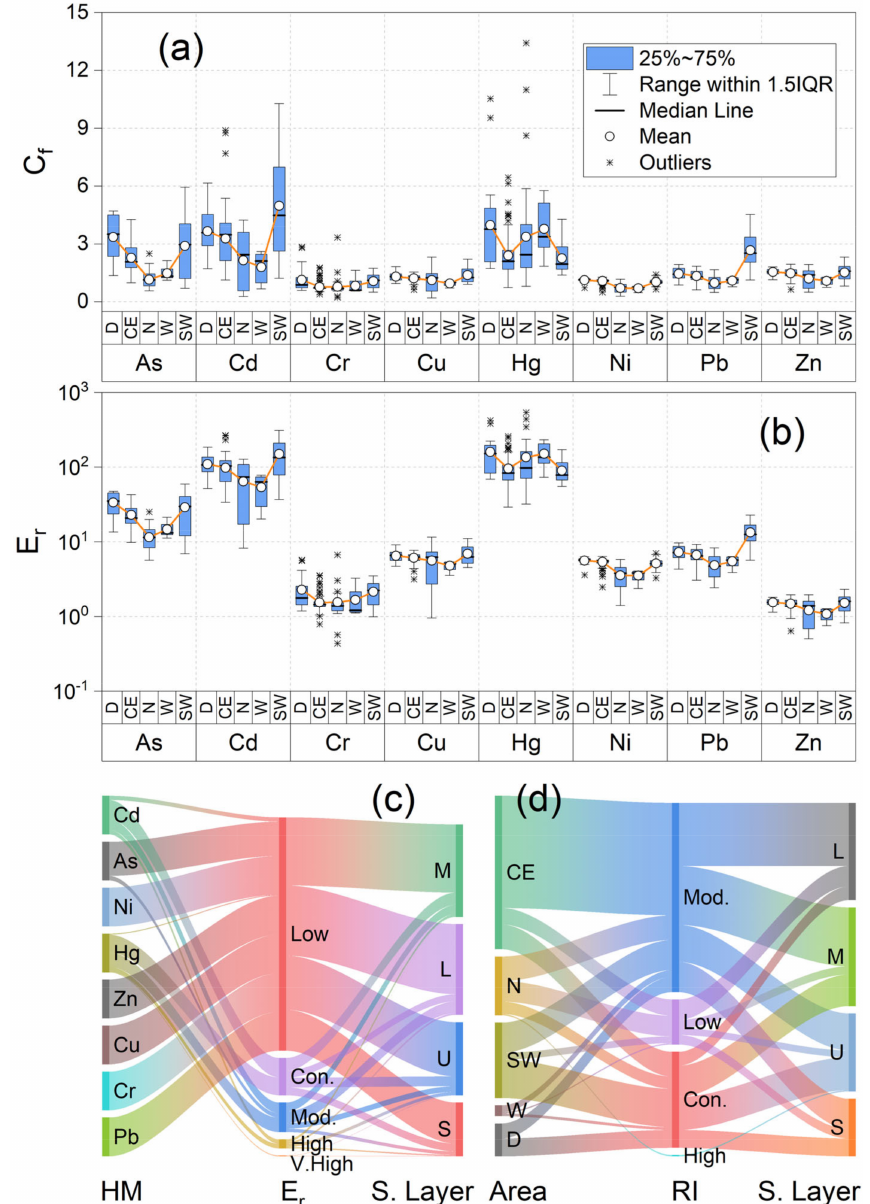
Figure 3. Contamination level and potential ecological risk of heavy metals in sediments of the Tongjiqiao Reservoir: ( a ) boxplot of C f for heavy metals, ( b ) boxplot of E r for heavy metals, ( c ) Sankey plot of E r for heavy metals, and ( d ) Sankey plot of RI for heavy metals. In ( a , b ), D, CE, N, W, and SW represent areas next to the main dam, central and eastern, northern, western, and southwestern regions of the reservoir, respectively. In ( c , d ), Low, Mod., Con., High, and V. High signify that E r or RI are at a low, moderate, concentrated, high, or very high level/risk, respectively. S, U, M, and L represent the surface, upper layer, middle layer, and low layer sediments, respectively. S. Layer represents the sediment